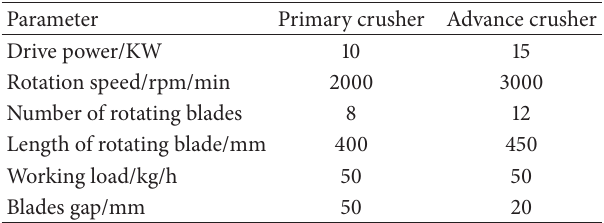
Table 1: Technical parameters of the lab-scale crushing system.